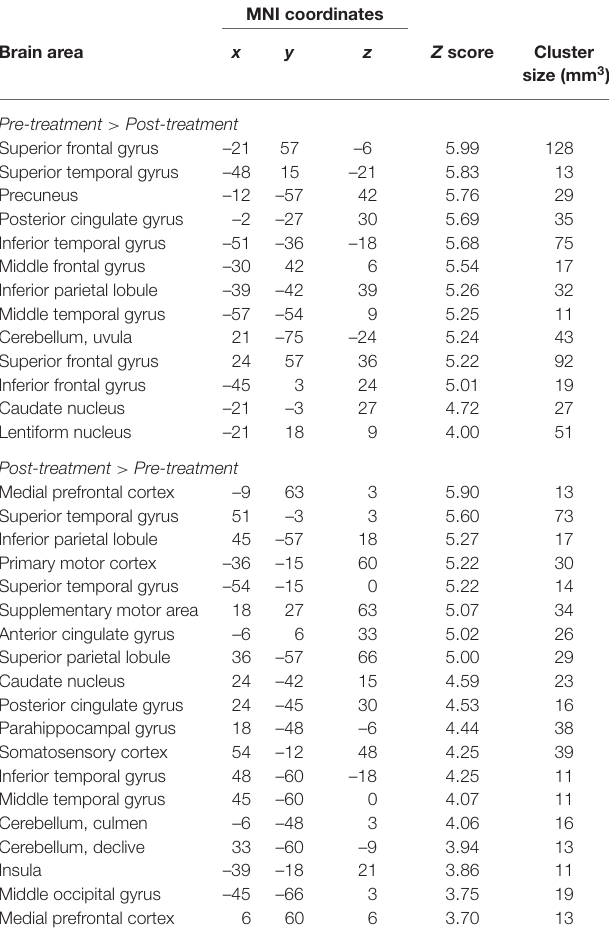
TABLE 3 | Regions showing the significant differences in resting-state functional connectivity between pre-treatment and post-treatment. MNI coordinates Brain